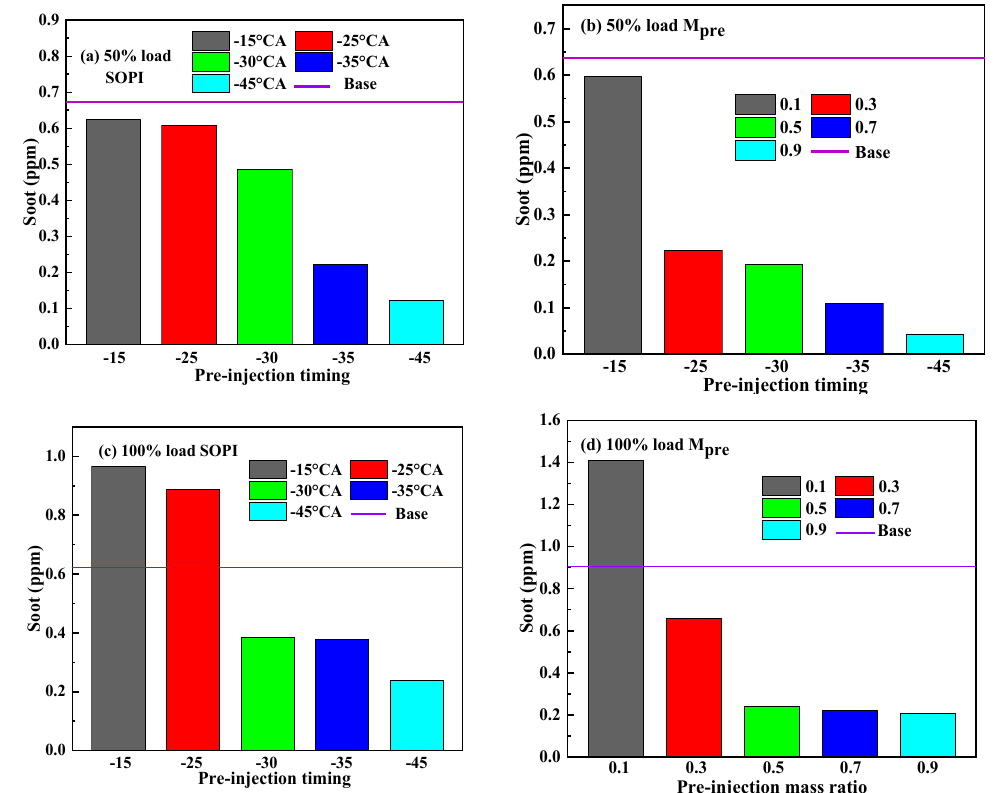
Figure 11. Comparisons of soot emission under different load